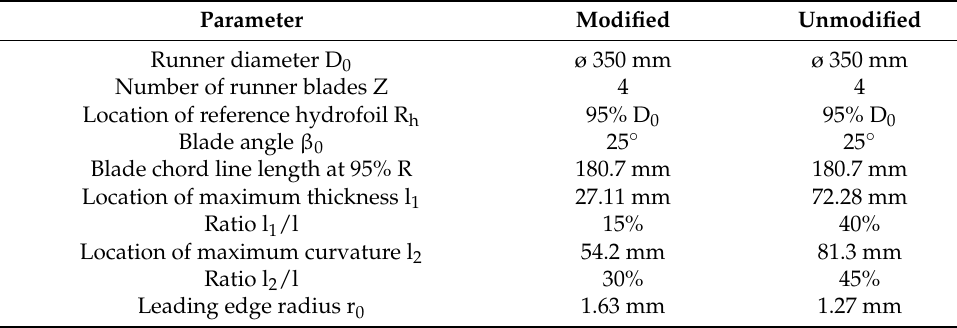
Table 1. Characteristics of hydrofoils as used on bulb turbine.